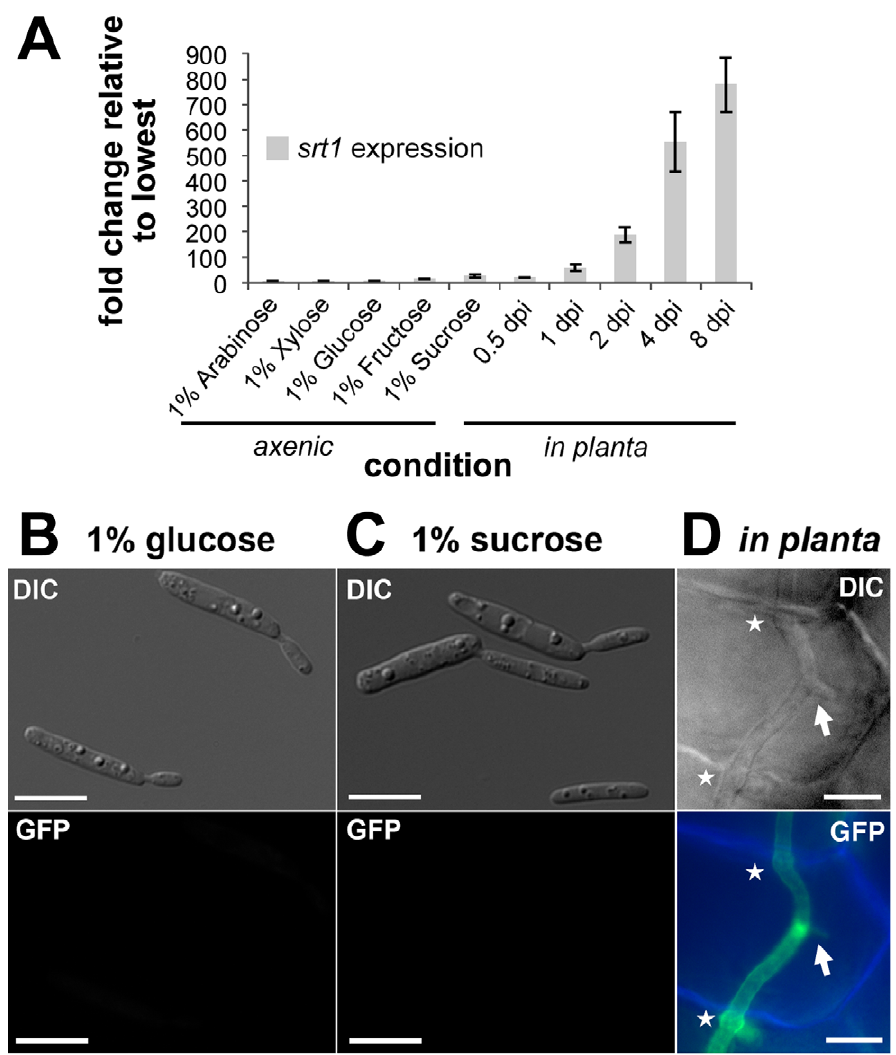
Figure 3. Srt1-GFP is specifically expressed in planta. (A) Expression profile (real-time PCR) of srt1 in SG200 grown in liquid media supplemented with different carbon sources (left) or on plant tissue at different time points after infection. Gene expression was normalized to the expression of the constitutively expressed genes actin and eIF2B . Changes in srt1 expression are displayed relative to the lowest expression value. (B) The SG200 D srt1 :: srt1 - GFP mutant shown to have a functional Srt1-GFP protein in Figure 3 was grown in minimal medium with 1% glucose. Cells were photographed in white light or under GFP excitation light (bottom). DIC, differential interference contrast microscopy. (C) SG200 D srt1 :: srt1 - GFP mutant photographed after growth in minimal medium with 1% sucrose. (D) In contrast to (B) and (C), hyphae of the SG200 D srt1 :: srt1 - GFP mutant show Srt1::GFP-derived fluorescence when monitored after infection of plant tissue (3 dpi). A DIC image (top) and two merged fluorescence images (blue indicates autofluorescence of plant cell walls; green, Srt1::GFP fluorescence of fungal hyphae) are shown. Arrows point towards clamp cells, which are formed by U. maydis only during in planta growth. Asterisks mark cell-to-cell penetration points. Bars represent 10 m m.